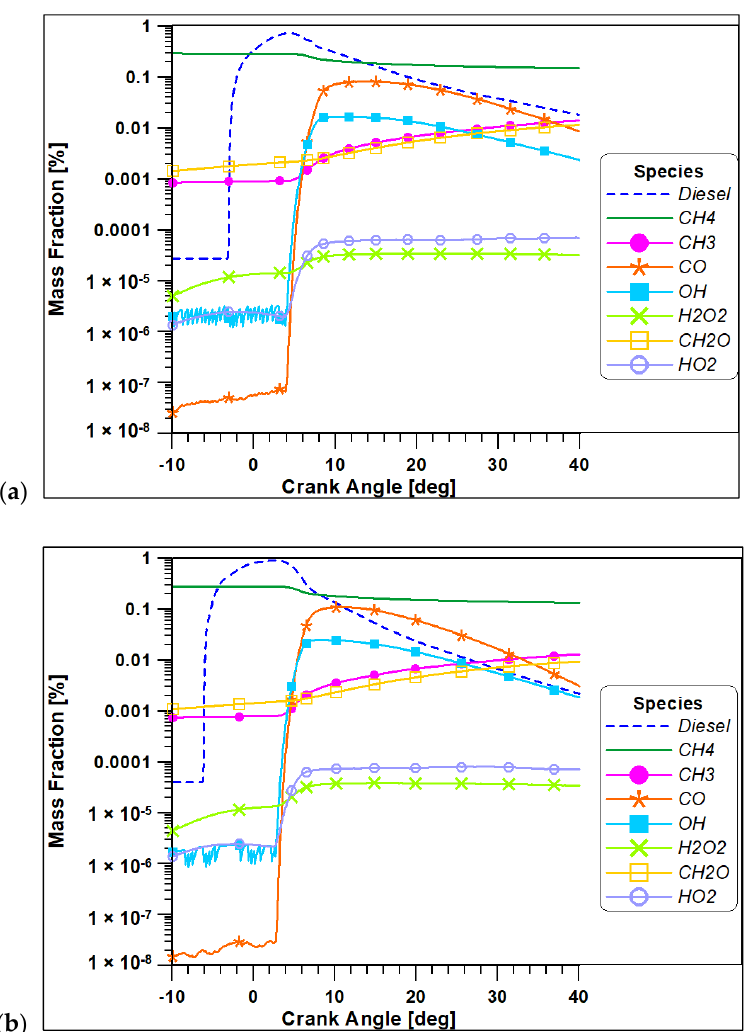
Figure 8. Species evolution for the RP = 22%: ( a ) 1500 rpm and ( b ) 2000 rpm.